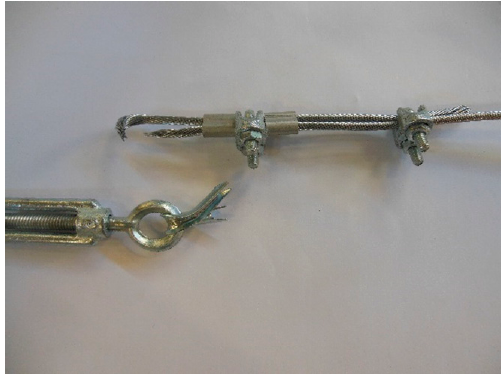
Figure 38. Failure mechanism of Specimen 6.